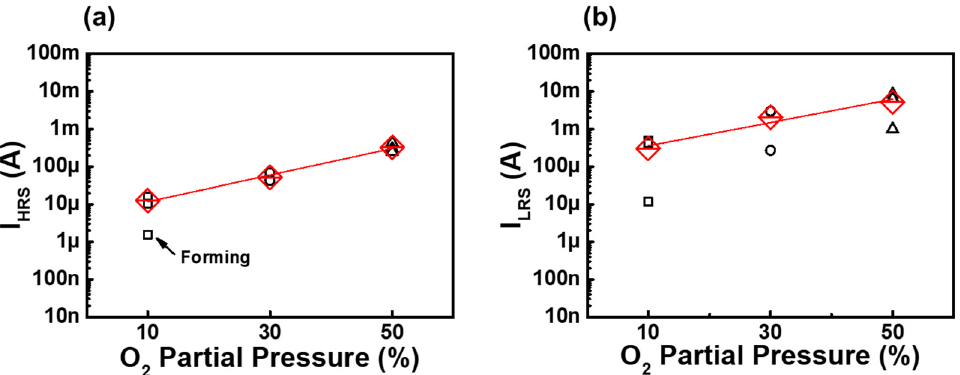
Figure 3. Influence of oxygen partial pressure on ( a ) I HRS of Ni 1 − x O films and ( b ) I LRS of Ni 1 − x O films. The DC, and AC endurance characteristics of the Ni 1 − x O device are shown in Figure S1. DC endurance in Figure S1a was measured at a read voltage (V read ) of ± 0.25 V under a compliance current of 10 mA. The measured I HRS /I LRS ratio is higher than 10 1 even after 10 3 cycles. Figure S1b shows the AC endurance under pulse, which is measured with a set pulse of − 0.95 V with 180 ns, a reset pulse of 1.2 V with 180 ns, and a V read of 0.3 V conditions. The device has a uniform I HRS /I LRS ratio even after 10 5 cycles, which results in a stable RS